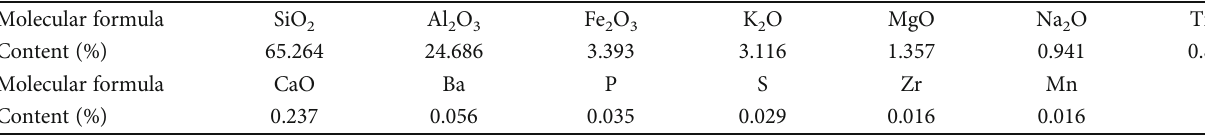
Figure 3: X-ray di ff raction diagram of silty mudstone. Table 1: XRF analysis of silty